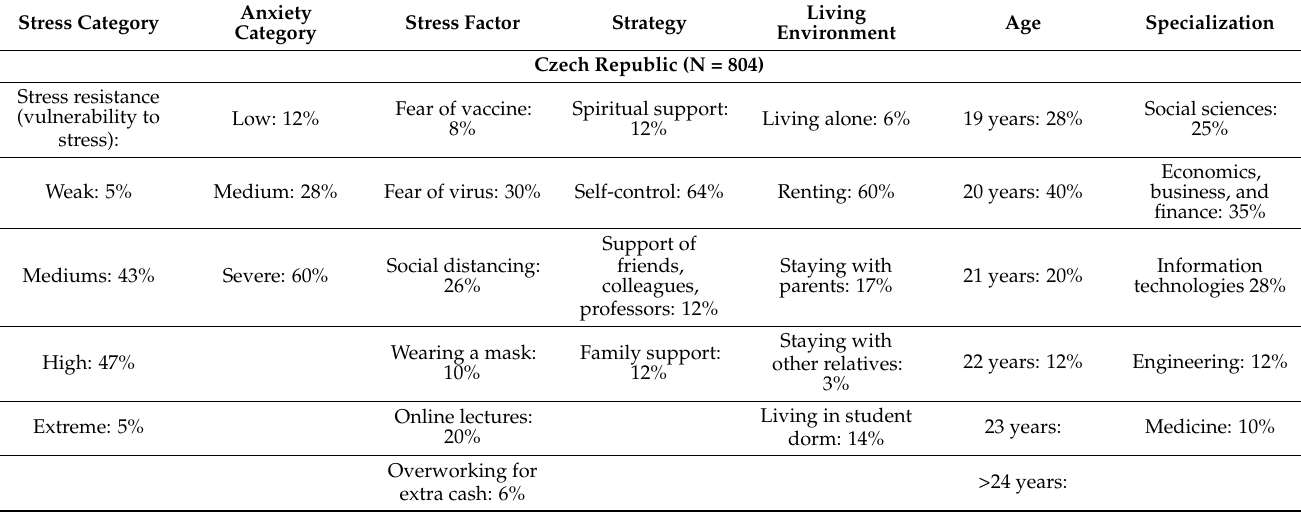
Table 1. The distribution of students according to various variables (relative frequencies expressed in